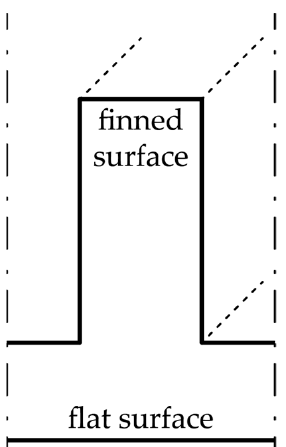
Figure 5. Increased surface area relative to a flat surface by use of fins.